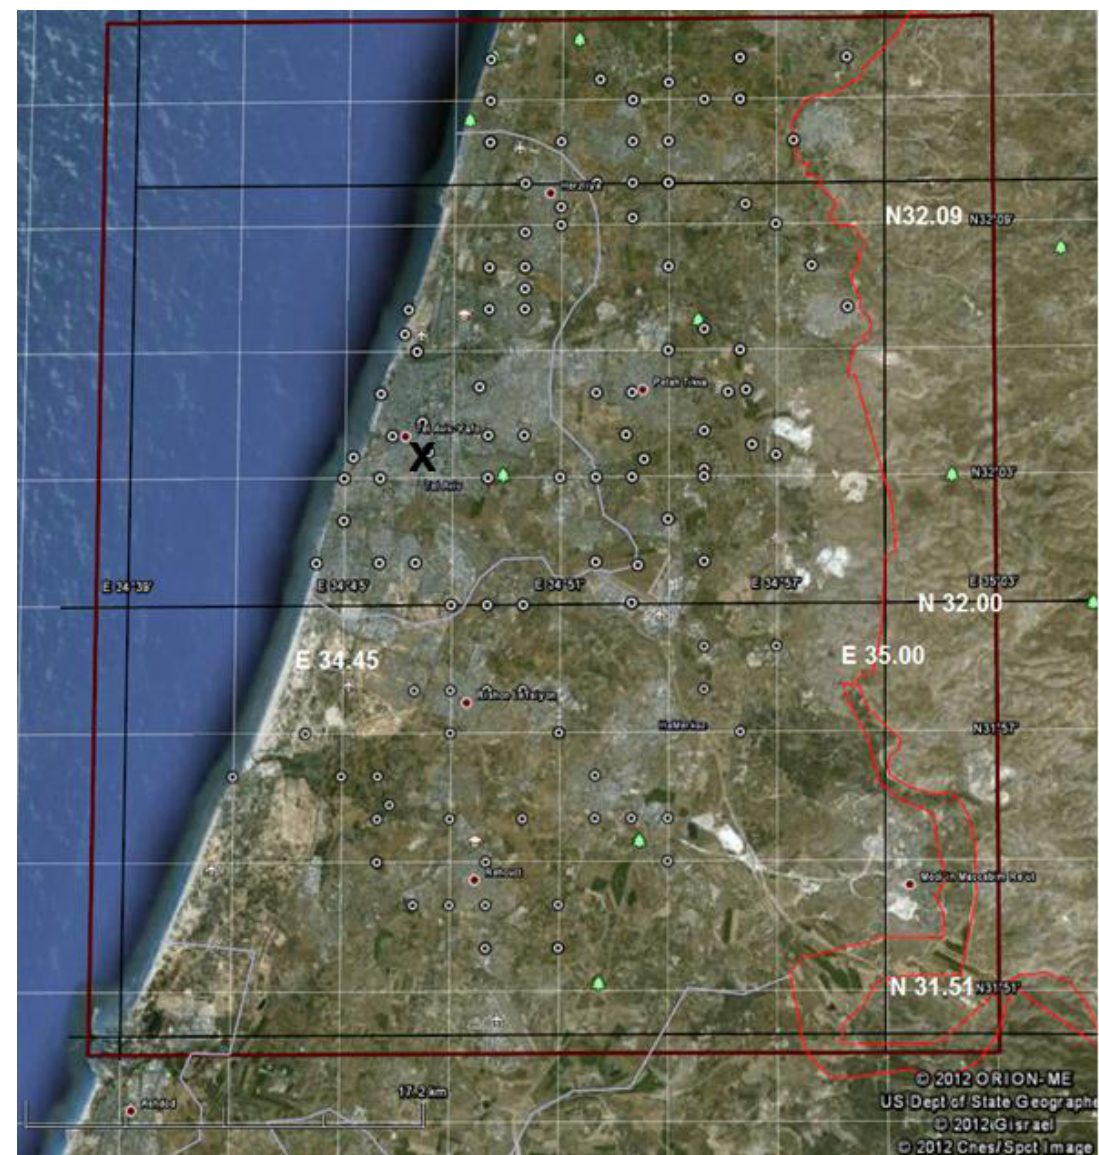
Figure 3. The study area and the Israel Meteorological Service (IMS) rain stations (over 100 stations, denoted by circles) employed here. The study area is indicated by the red rectangle. For more detail see text. Tel-Aviv city center is located at about (32°04 ’ N, 34°47 ’ E), and is denoted by an X.